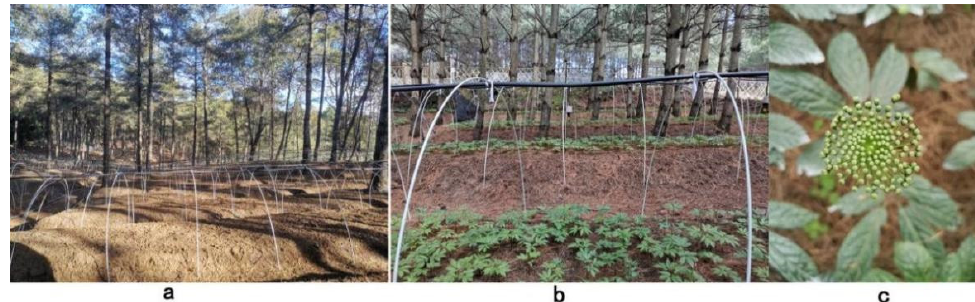
Figure 4. Schematic diagram of the P. notoginseng - pinus agroforestry system planting pattern. ( a ): woodland not planted with Panax ginseng ; ( b ): woodland planted with Panax ginseng ; and ( c ): Panax ginseng flower.